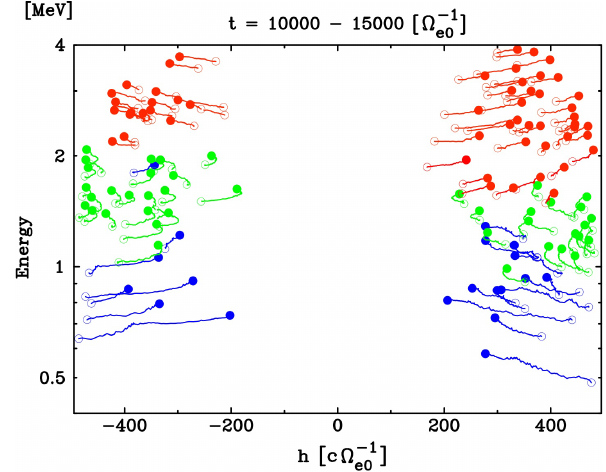
Fig. 4. Examples of trajectories of accelerated electrons during the time interval, t = 10000 (cid:127) − 1 –15000 (cid:127) − 1 . Blue, green and red e 0 e 0 curves show trajectories of electrons accelerated through the normal trapping, RTA and URA processes, respectively. Open and filled circles respectively indicate trapping and detrapping points on each trajectory. In the energy range corresponding to γ<(cid:127) e (cid:14) ω , trapped electrons move toward the magnetic equator during their accelera- tion. For a trapped electron satisfying the RTA turning condition γ = (cid:127) e (cid:14) ω , the resonance velocity becomes zero due to the relativis- tic effect and eventually changes sign, thereby resulting in the turn- ing motion. Since the gyro-frequency of highly relativistic electrons is smaller than the frequency of chorus waves, trapped electrons then move in the direction of the chorus emissions that are mov- ing away from the equator. Highly relativistic electrons trapped by multiple chorus elements can undergo multiple URA